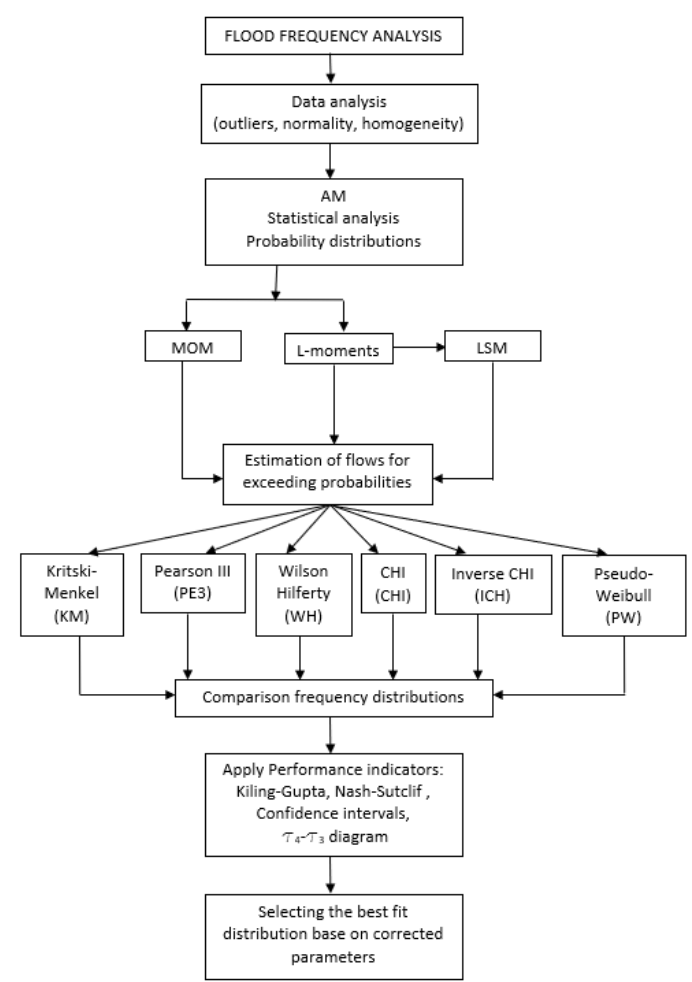
Figure 4. Methodological approach.